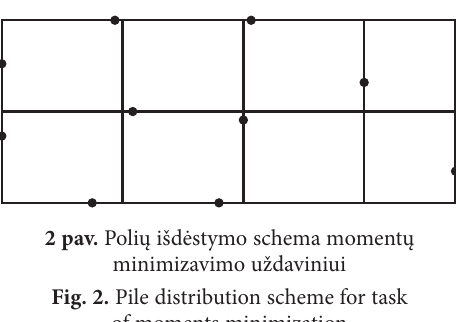
Fig. 2. Pile distribution scheme for task